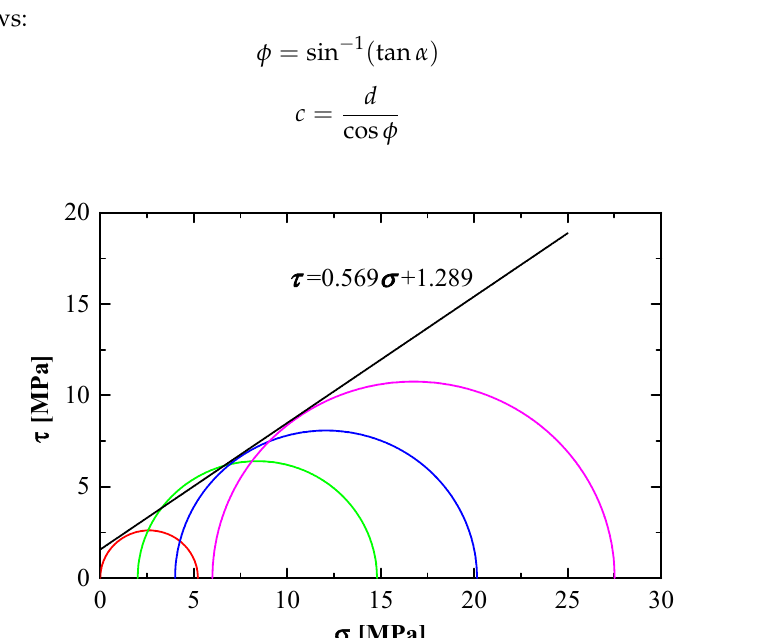
Figure 7. Relationship between mole circle and strength envelope (at –15 °C).